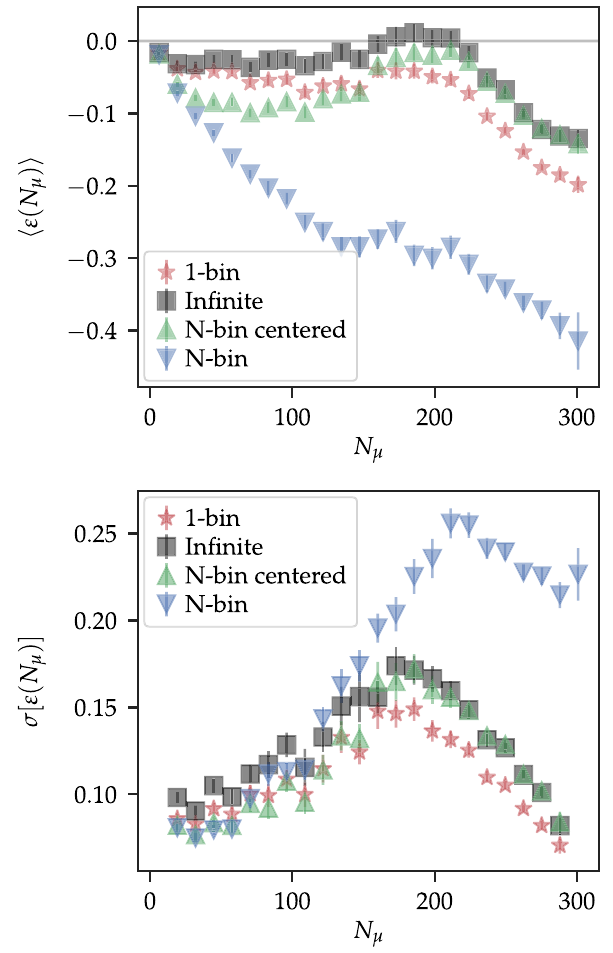
Fig. 8 Relative bias (top) and relative standard deviation (bottom) in the reconstructed number of muons as a function of the input number of muons for the four strategies considered. The detector-simulations set is the same as that of Fig. 7